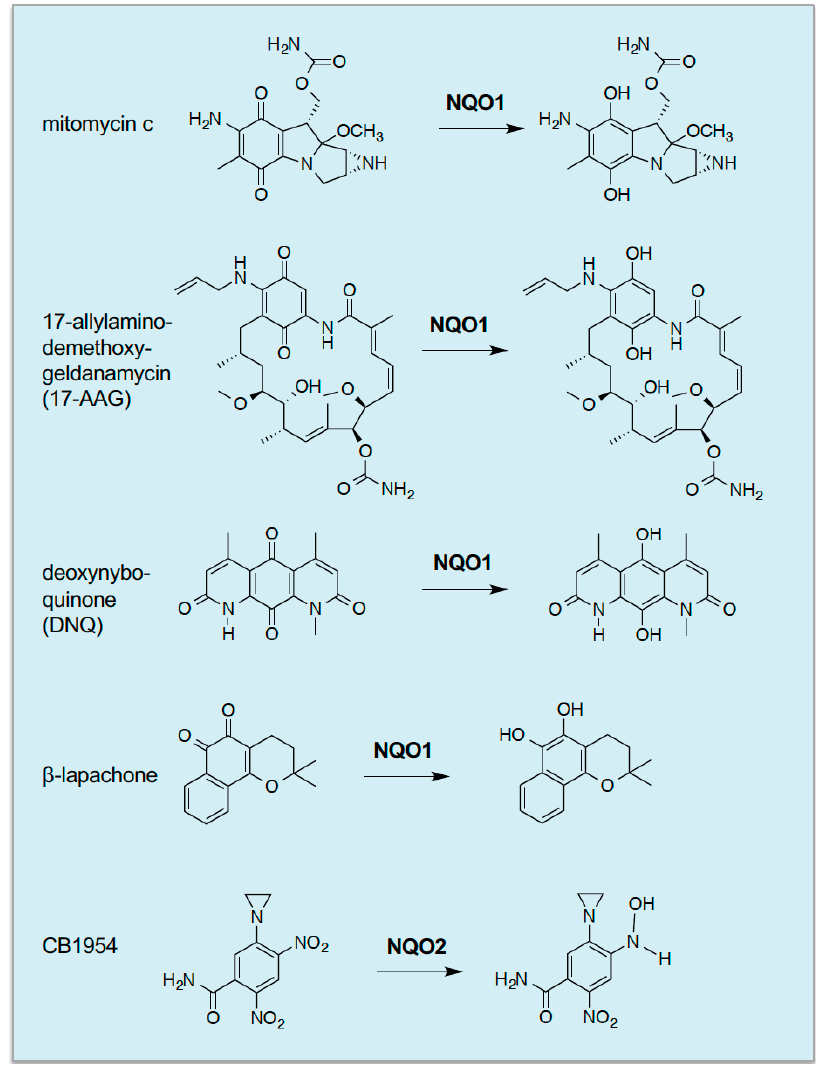
Figure 6. Chemicals activated by NQO1 and NQO2. The structures of mitomycin C, 17-allylaminodemethoxygeldanamycin, deoxynyboquinone, β -lapachone and CB1954 (Tretazicar), which are bio-reductively activated by NQO1 and NQO2, are shown.